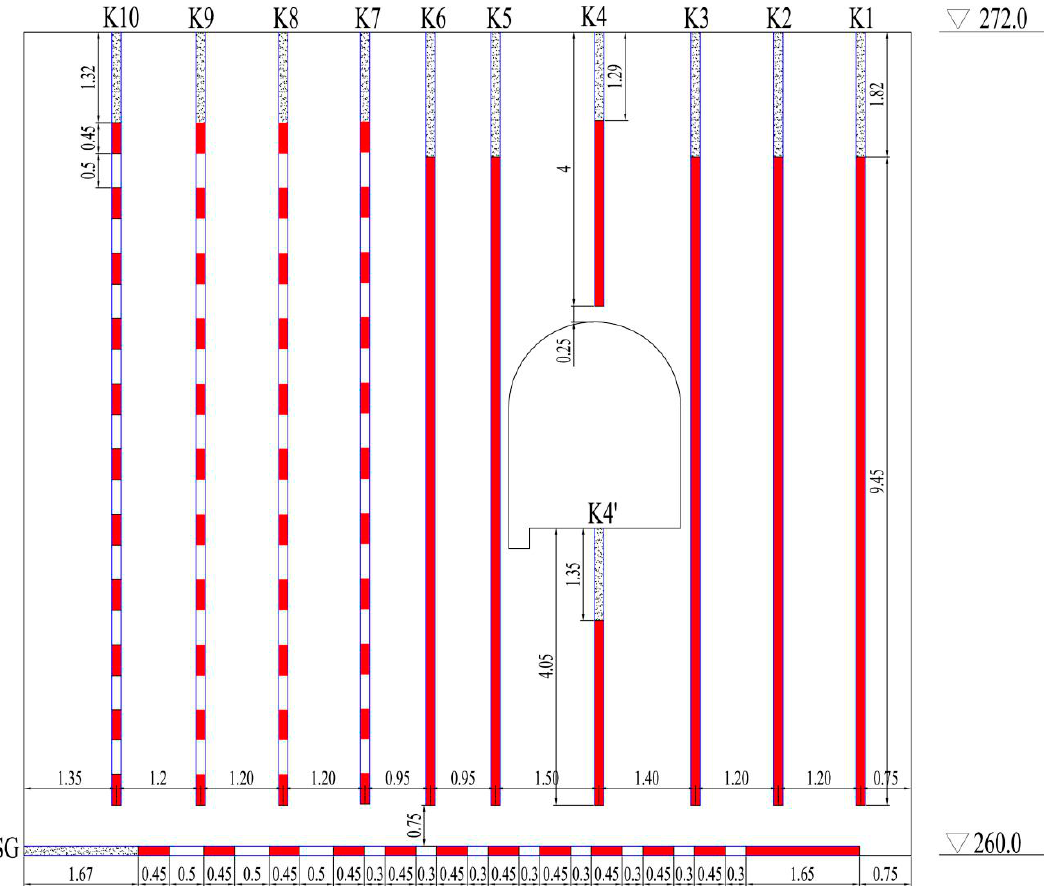
Figure 12. B-B’ profile charge structure of region Ⅴ and region Ⅵ (unit:m).